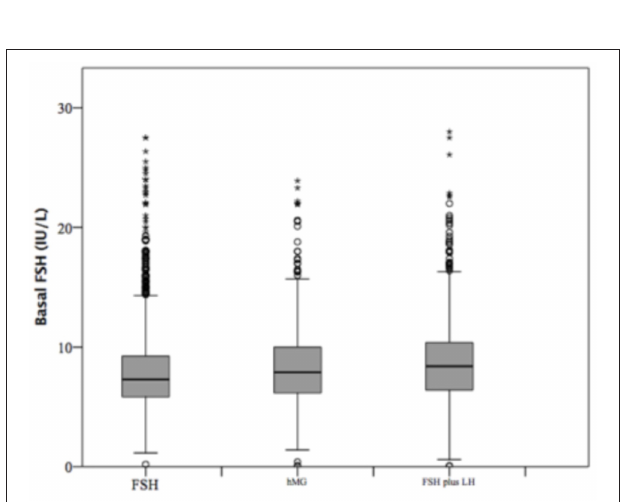
FIGURE 3 | Basal follicle stimulating hormone (FSH) serum levels among groups of patients, divided according to gonadotropins regimen chosen.